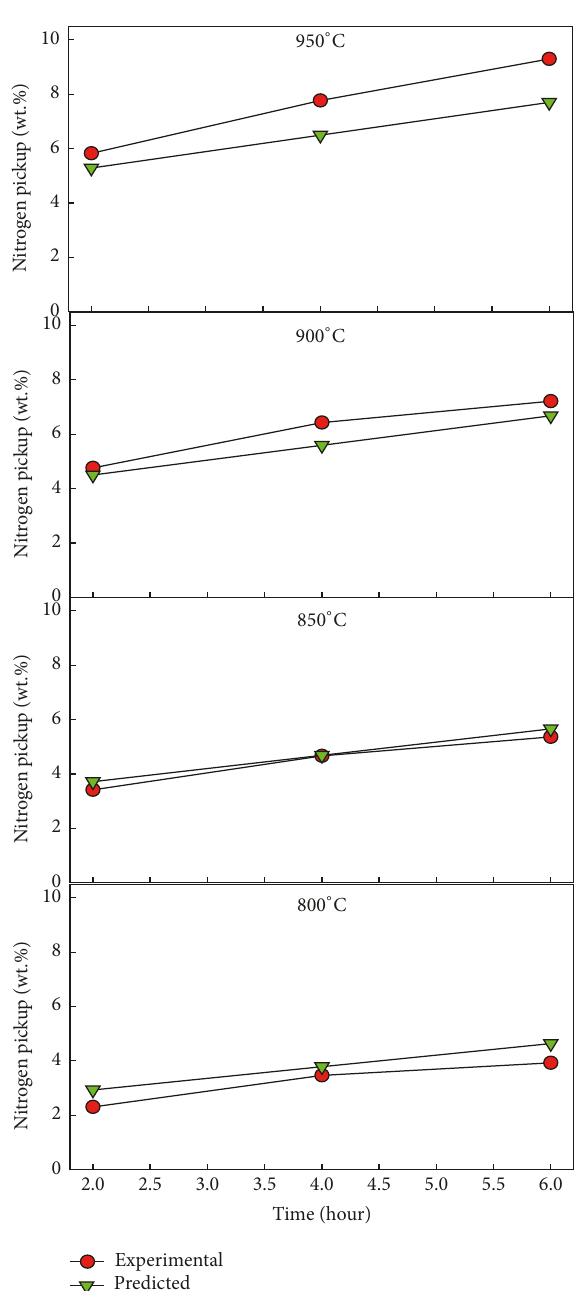
Figure 6: Variation between the predicted and published nitrogen pickup of low carbon (0.23% C) ferromanganese at 6-bar nitrogen pressure at different temperature and time [28,